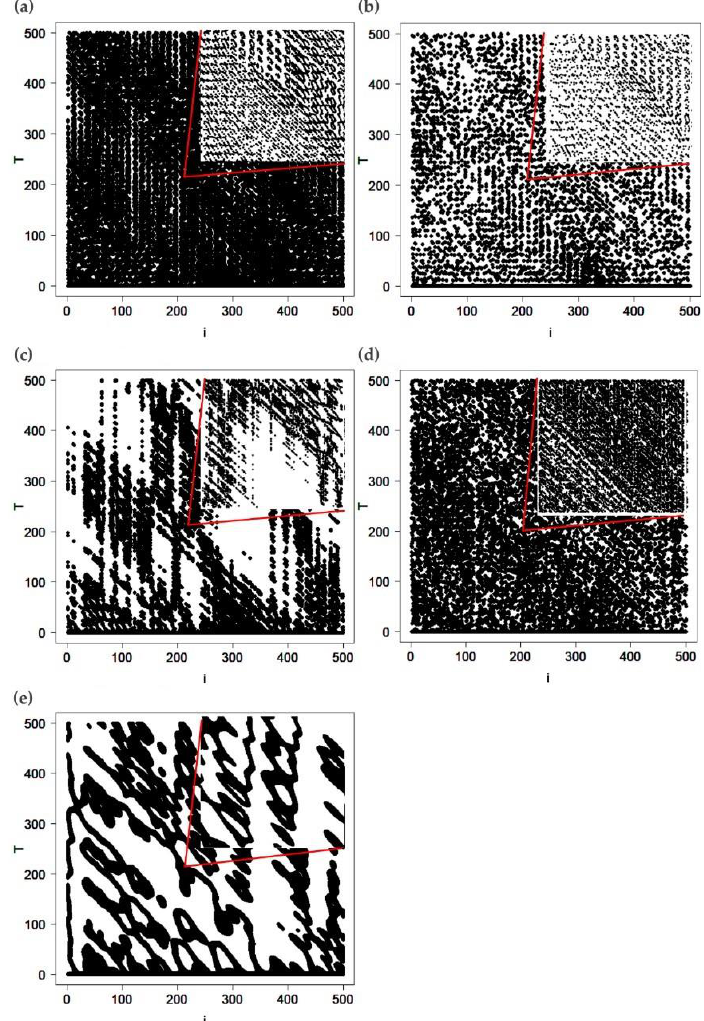
Figure 11. Close returns plot for ( a ) water level time series, ( b ) tide component, ( c ) wave component, ( d ) rainfall-runoff component, and ( e ) noise component when r = 0.005.